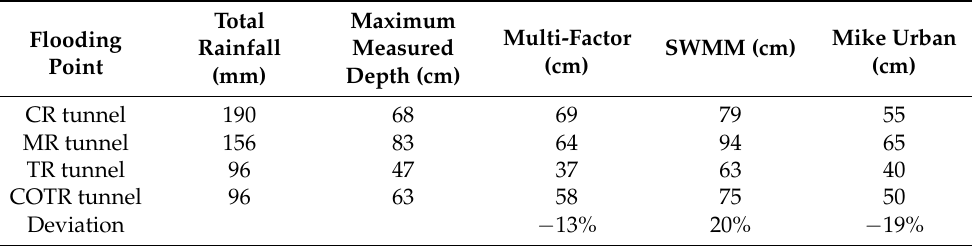
2020 by the (a) CR tunnel, (b) MR tunnel, (c) TR tunnel, and (d) COTR tunnel.